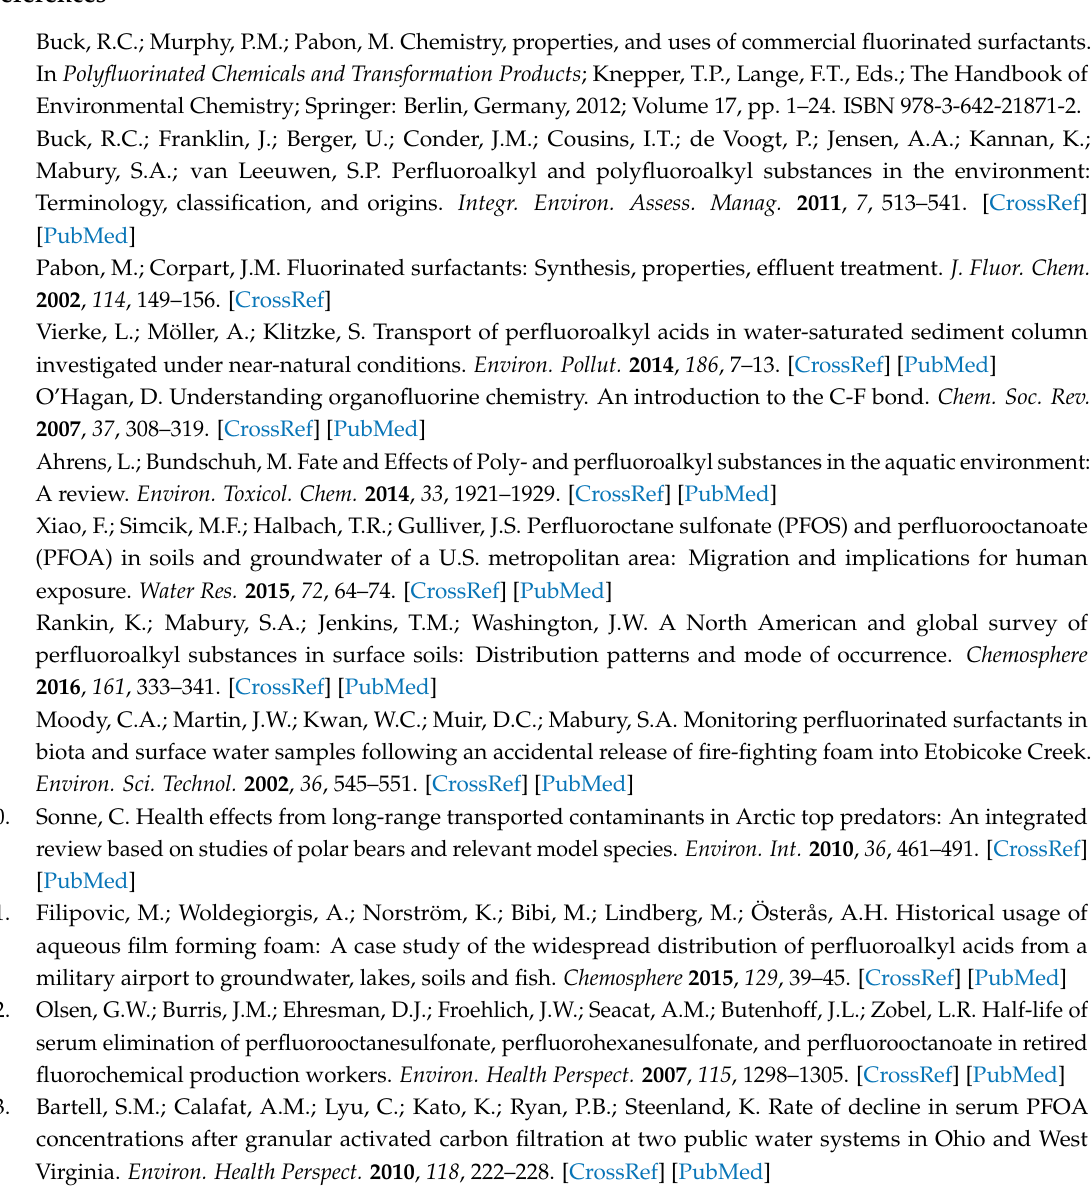
Table S1: PFOA concentrations in ng/L at former Pease AFB; Table S2: PFOS concentrations in ng/L at former Pease